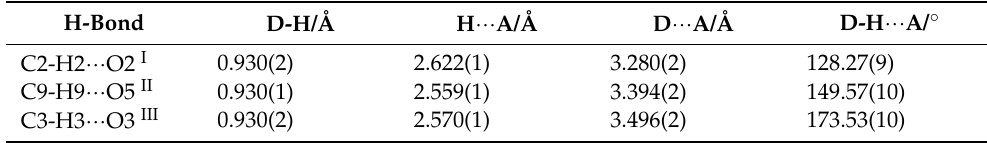
Figure 2. ( A ) Stick-spacefill model of 1 evidencing the stacking interactions between the aromatic moieties of the molecule, viewed along the c axis. Hydrogens are omitted for the sake of clarity. ( B ) Stick model of 1 showing the main H-bonds, viewed along the b axis. ( C ) Crystal packing of 1 , viewed along the c axis. Hydrogens are omitted for the sake of clarity. Table 1. H-bond geometry (D: Donor, A: Acceptor).